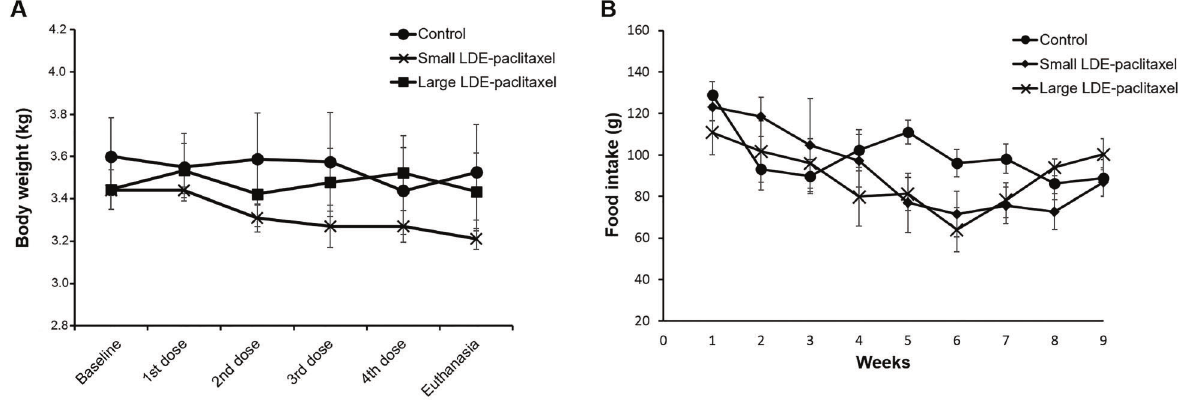
Figure 1. Body weight and food intake. A , Body weight (kg) of small lipid nanoparticles (LDE)-paclitaxel and large LDE-paclitaxel groups. B , Food intake (g) of the same groups. Data are reported as means ± SE, using one-way ANOVA with Bonferroni ’ s post-test.